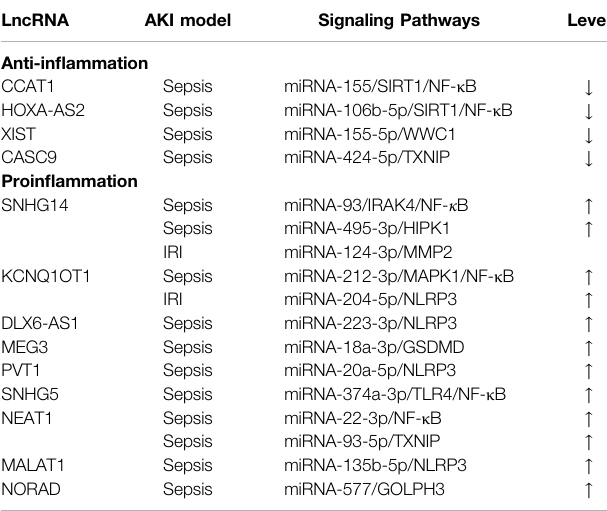
TABLE 2 | Role of lncRNAs in in fl ammatory response of